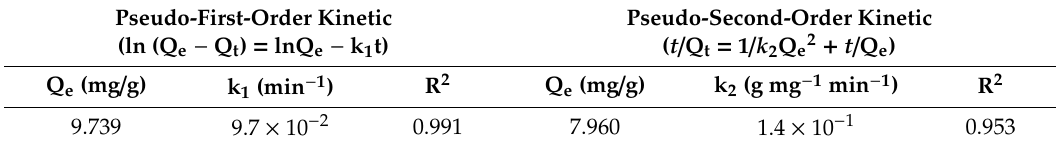
Table 2. The kinetic constants for removal of antimony using BP.